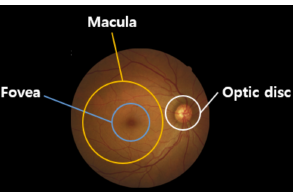
Figure 1. A normal fundus photograph of a right eye.